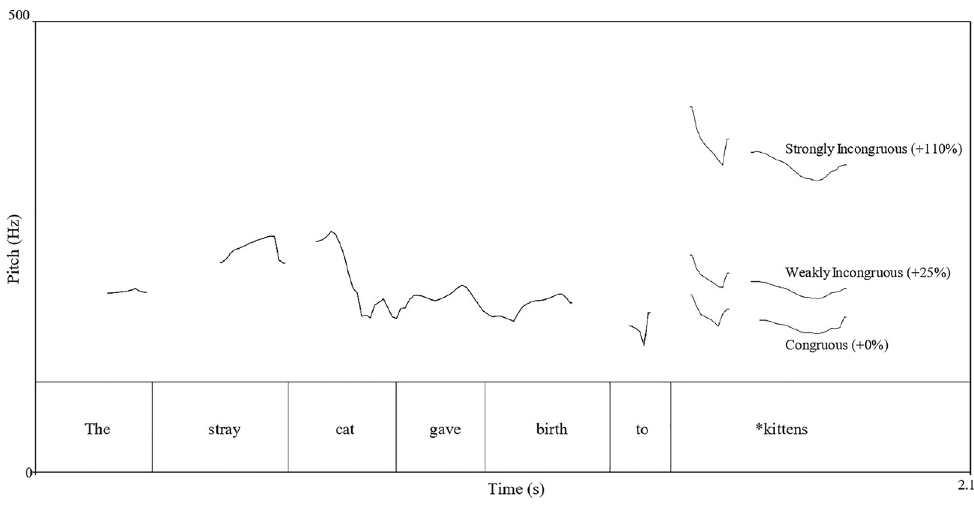
Figure 1. Fundamental frequency (F0 in Hz) for a sample sentence in the three prosodic